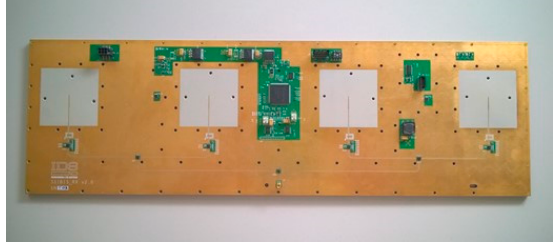
Figure 8. Receiving antenna module.